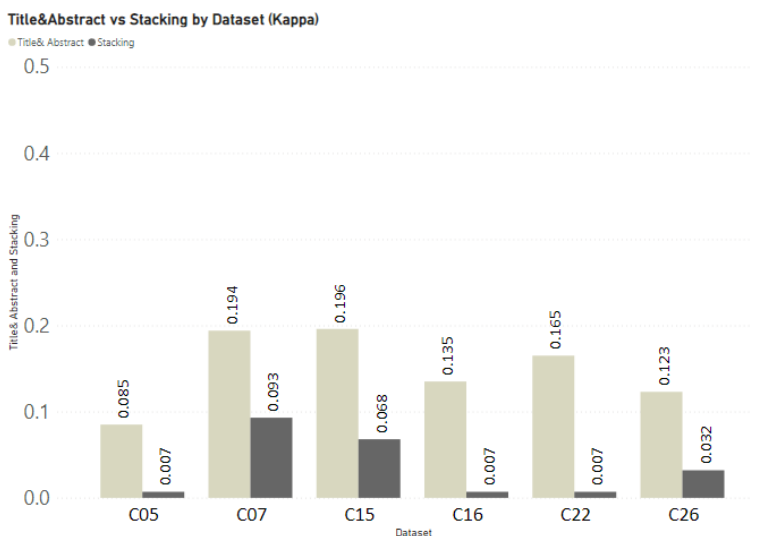
Figure 6. Kappa values of the OHSUMED datasets where Title–Abstract (TA) is the best statistically tested